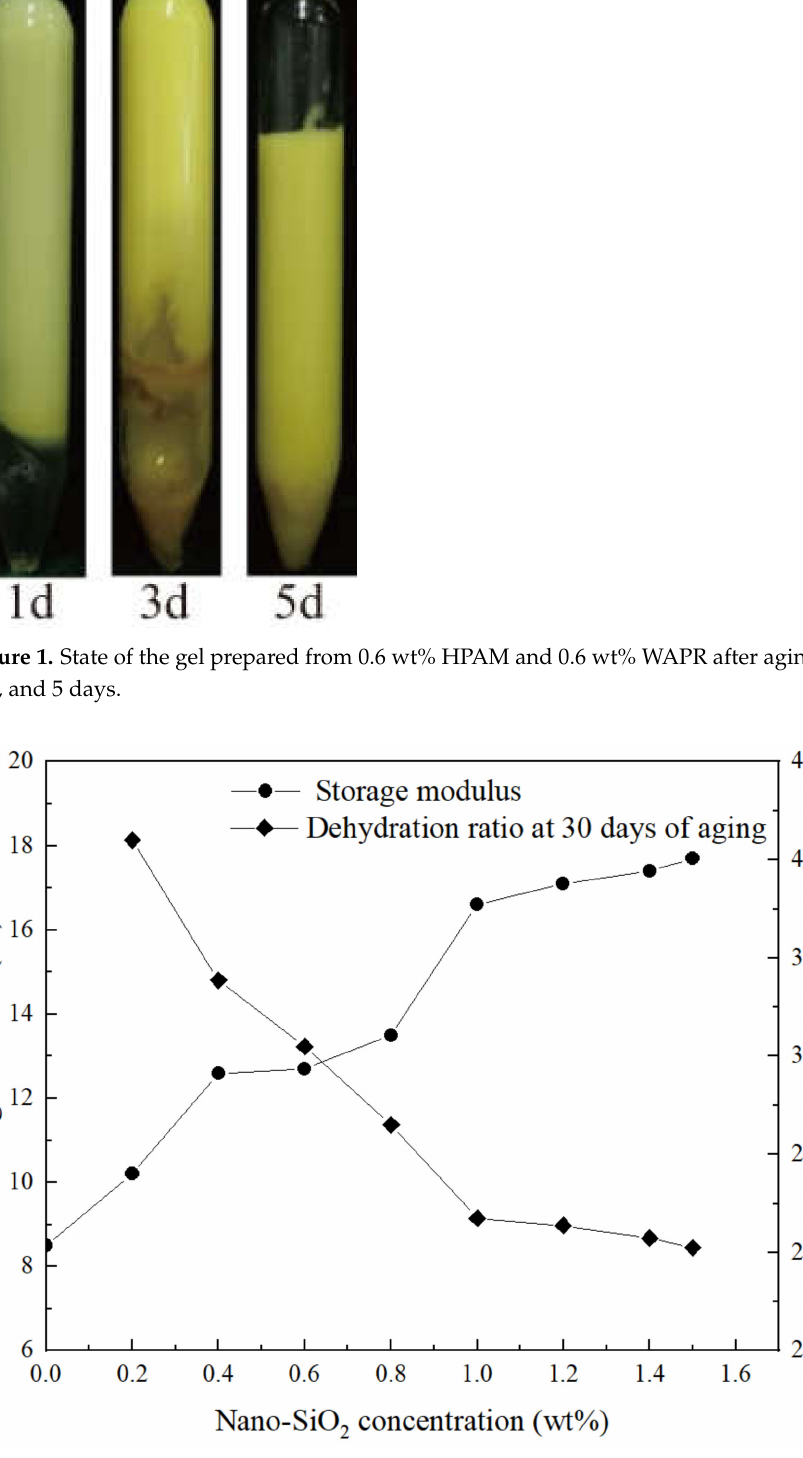
Figure 2. Effect of nano-SiO 2 dosage on the gel strength and thermal stability of gels containing 0.6 wt% HPAM, 0.6 wt% WSPR, and different concentrations of nano-SiO 2